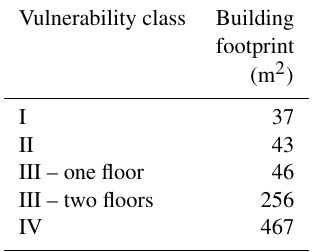
Table 5. Cell areal extent of different land-use categories in Ethiopia as a percentage of the country area according to different products (original dataset